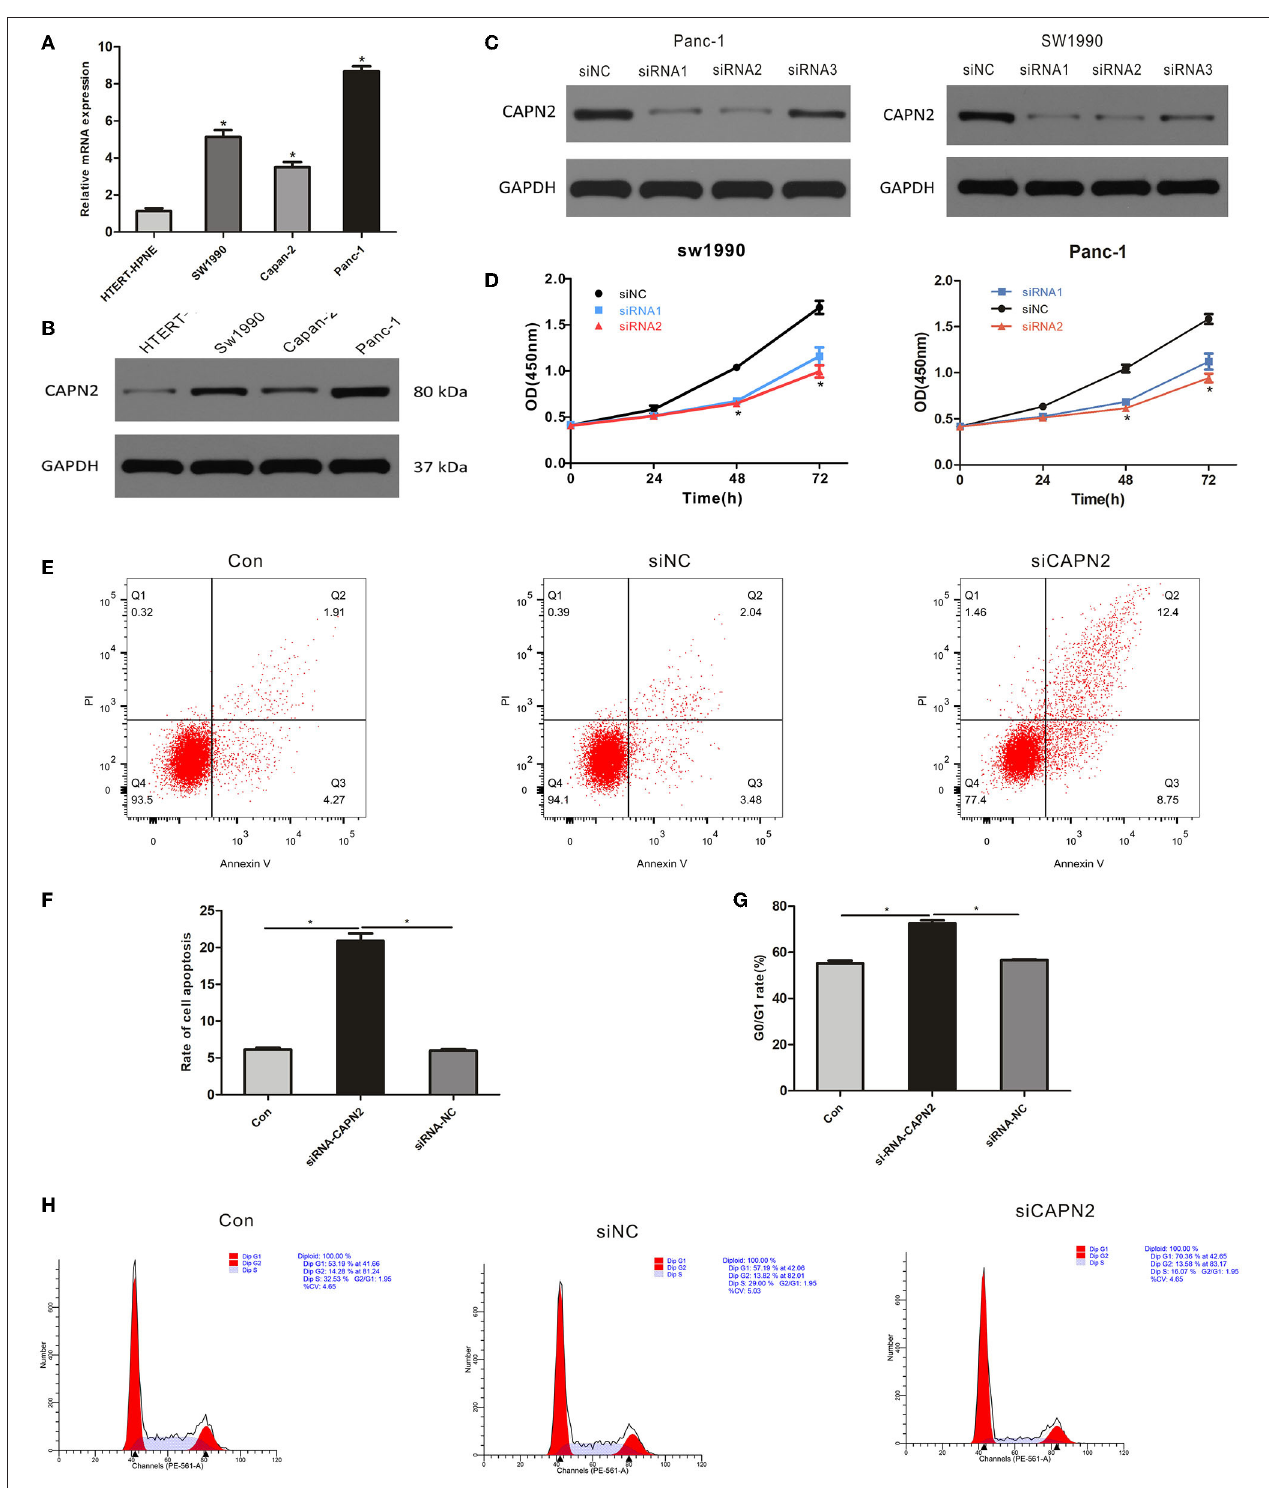
FIGURE 5 | CAPN2 expression regulates the proliferation and survival of PC cell lines (A,B) qRT–PCR and Western blot analysis of CAPN2 expression in the three PC cell lines Sw1990, Capan-2, and Panc-1 and the normal human pancreatic duct cell line HTERT-HPNE. (C) Knockdown effects of CAPN2 were confirmed by Western blotting analyses. (D) Proliferation of CAPN2-depleted cells and control cells at 24 h, 48 h, and 72 h was determined by the CCK-8 assay. (E,F) The effect of CAPN2 on the apoptotic rate in PC cells at 48 h was determined by flow cytometry analysis. Representative images and the quantitative analysis of the apoptotic rate in siCAPN2 #2-transfected Panc-1 cells and control cells. (G,H) Cell cycle analysis results from CAPN2 knockdown and control Panc-1 cells (48 h). Representative images and quantitative analysis of G0/G1-phase arrest are shown here. * P < 0.05.